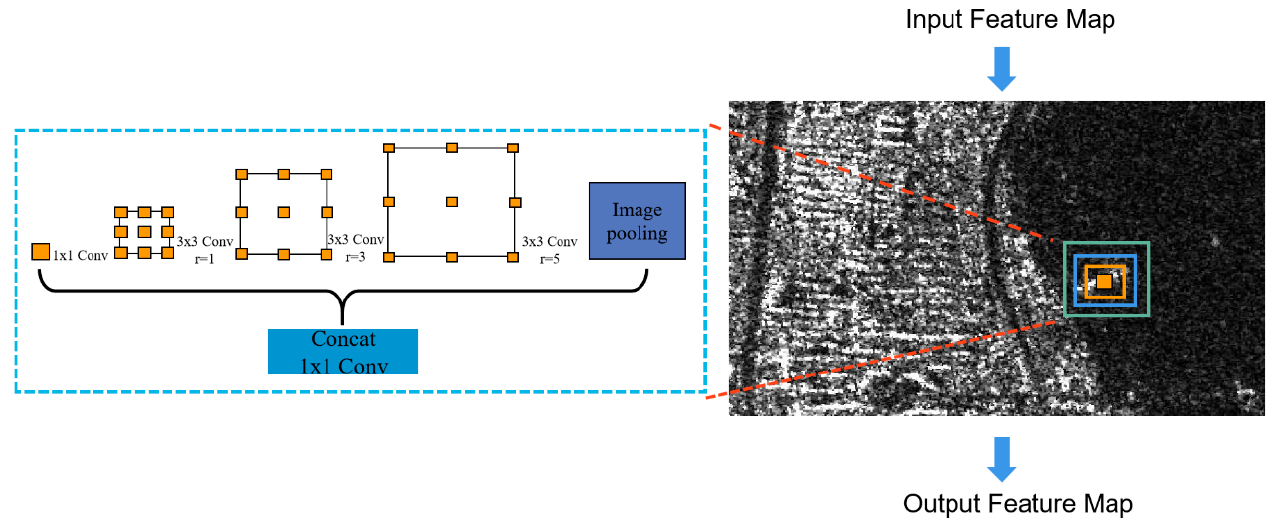
Figure 5. Multi-scale feature extraction; various receptive fields result from various dilation rates.